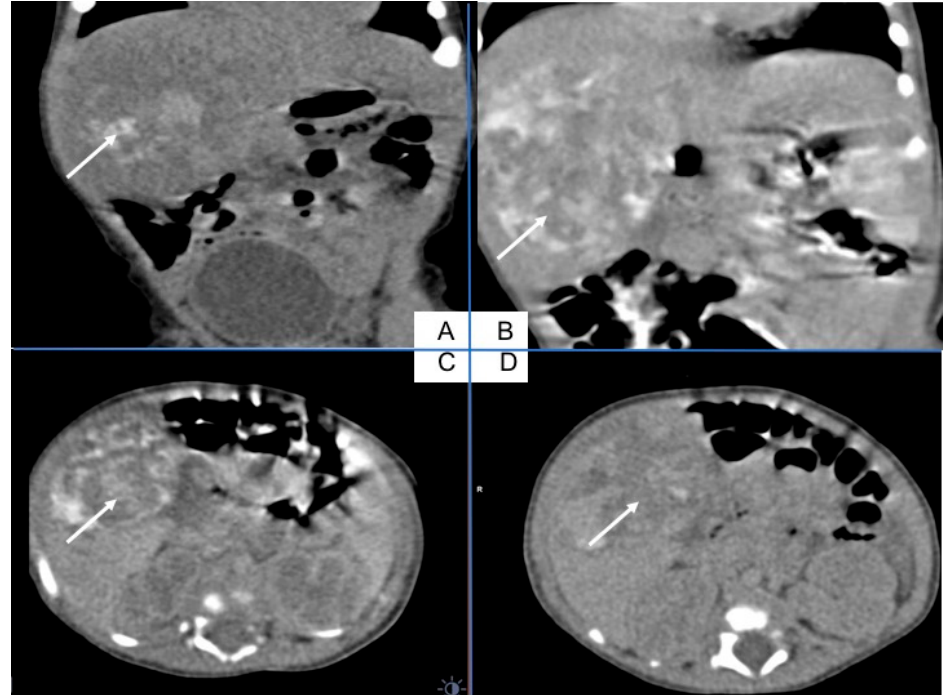
Figure 2. Abdominal CT with liver tumor in the right lobe. An abdominal nonenhanced ( A ) and enhanced arterial phase ( B ) coronal view, arterial phase ( C ) and portal phase ( D ) axial view indicate on the hepatic mass with bleeding ( A ), and central necrosis. After gadolinium contrast injection, there is poor peripheral enhancement in the arterioportal phase ( C ) and in the late portal venous phase CT image shows poor hypodense lesions ( D ). An abnormal blood tests were anemia (Hb 6.1 g/dL), thrombocytopenia (77.000/uL), high BNP (1259 pg/mL), elevated total bilirubin (1.71 mg/dL), elevated LDH (651 IU/L), low fibrinogen (88 ng/dL), AFP (1110 ng/mL, but within the age limit) and an extremely high hCG level (2,813,000 IU/mL). The results of the CT and hCG tests authorized the urgent start of chemotherapy. A central catheter had to be inserted before treatment. Unfortunately, after surgery, due to significant respiratory efforts against tachypnoe and tachycardia, the infant was trans- ferred to the ICU and chemotherapy with ethoposide (100 mg/m 2 with a dose reduction acc. to the body weight) was started. Despite two days of chemotherapy and intensive treatment, the clinical condition deteriorated rapidly, massive malignant progression in the lungs (X-rays), in abdomen with intestinal and lymph nodes infiltration (USG), as well as in the CNS (USG) was observed. In fourth day of hospitalization, the patient died due to multiple organ failure. The post-mortem histopathological examination confirmed the diagnosis of disseminated choriocarcinoma. The child was in the ward with his father. The mother stayed at home because of vaginal bleeding. After receiving the results of the child’s hCG, the mother was urgently requested to the gynecological ward, where after curettage, a hydatidiform mole/chori- ocarcinoma was diagnosed (mother’s hCG was 37,600 IU/mL). The mother was treated with chemotherapy for 6 months (dactinomycin, etoposide, methotrexate acc. to FIGO - International Federation of Gynecology and Obstetrics protocol). Currently, one year after the occurrence of GTD, despite being advised not to conceive until her follow-up is com- plete, she is pregnant again. 3. Discussion